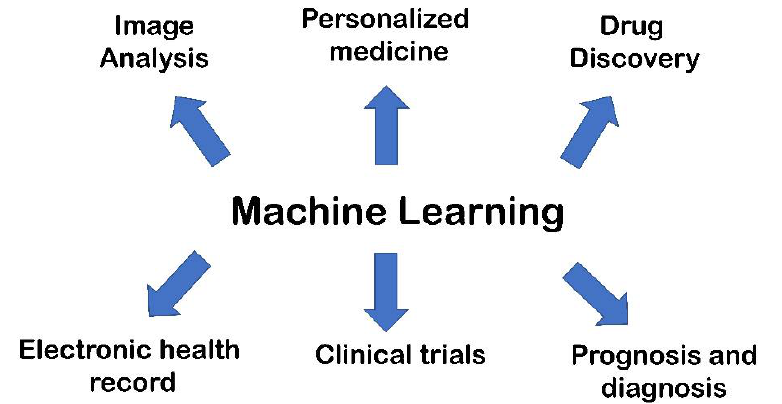
Figure 2. Schematic representation of the application of AI/ML in translational medicine.